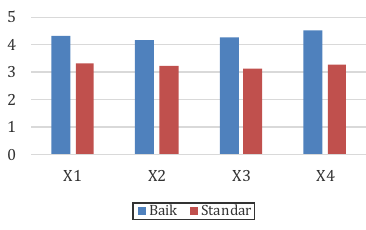
Figure 10. The chart car of Tanjung Pinang port centroid